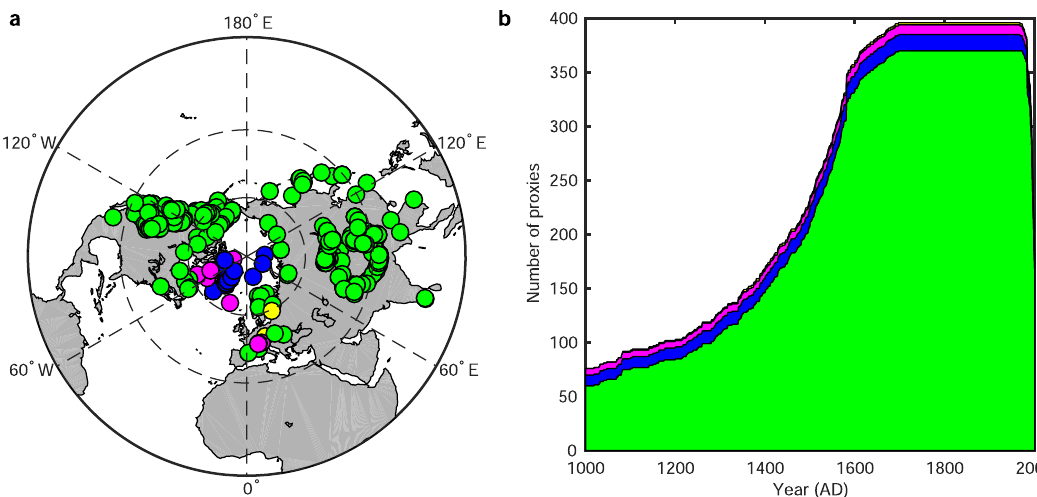
Fig. 1 Spatial and temporal distributions of multiple types of proxy data used in this study. a Spatial distribution of the 396 temperature-sensitive proxy data of different types. b Number of proxies over time used in our paleoclimate data assimilation-based temperature reconstruction. Green: tree ring proxy; Blue: ice core proxy; Magenta: lake sediment proxy; Yellow: historical document proxy.